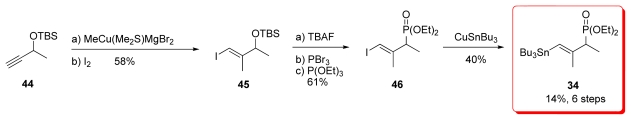
Preparation of phosphonate 34.